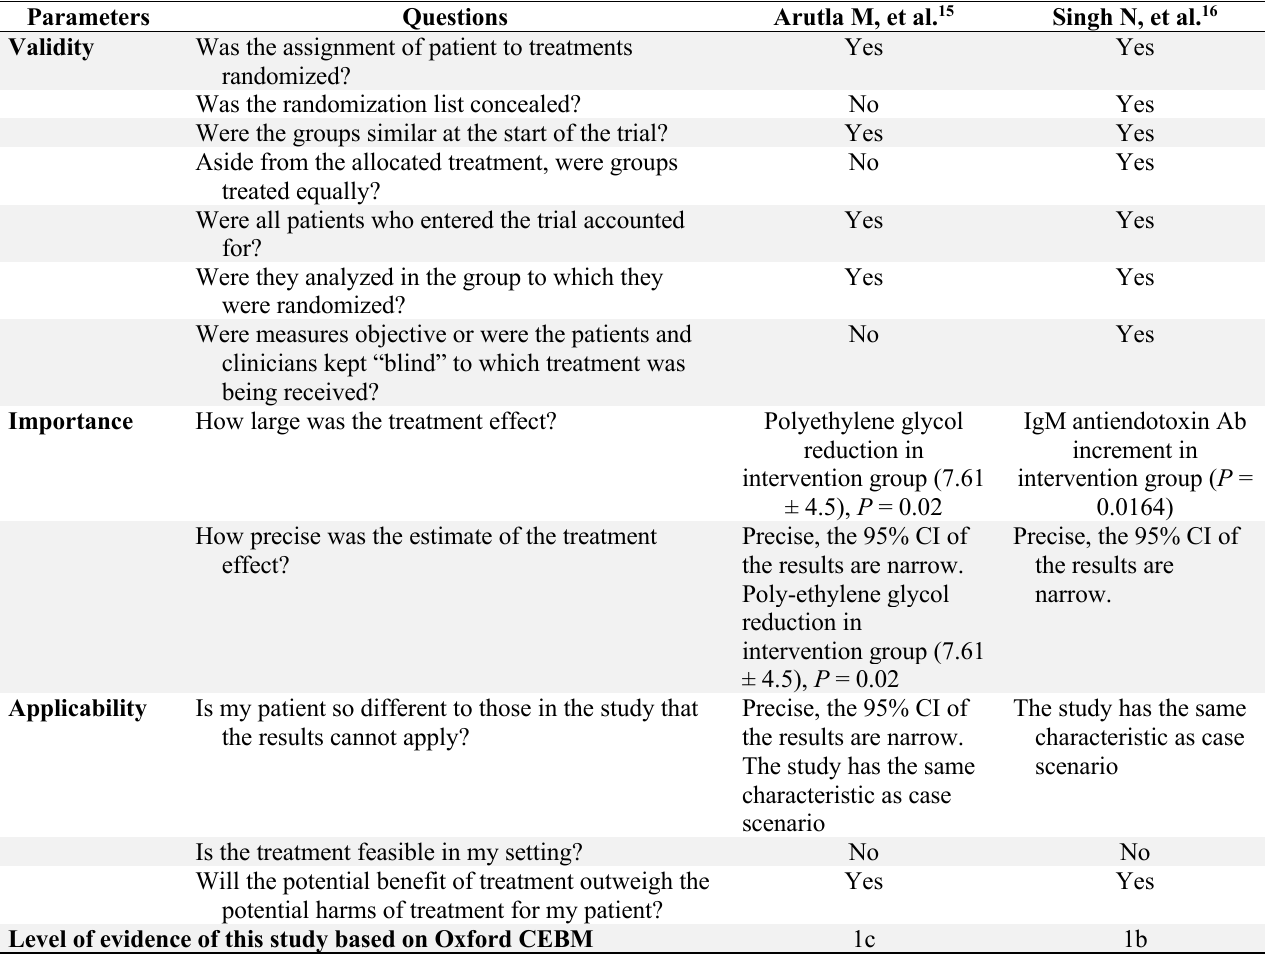
Table 2 . Critical appraisal of the RCT study based on criteria by Center of Evidence-Based Medicine, University of